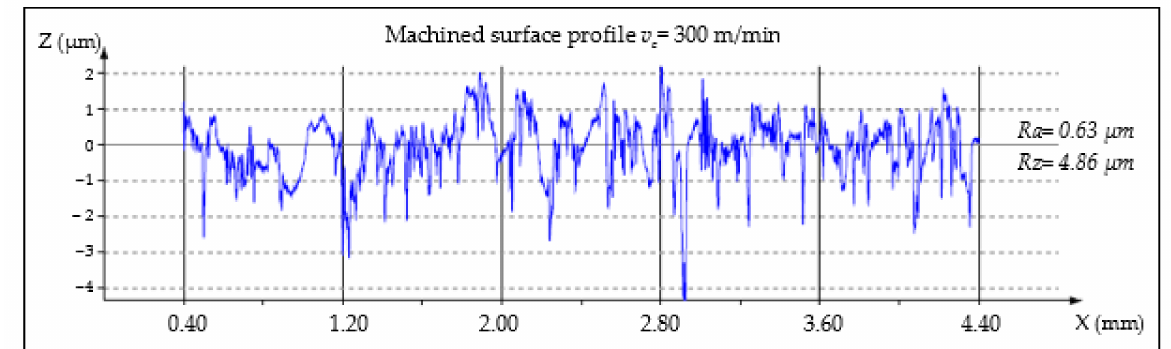
Figure 3. Machined surface profile of the AA359/SiC/10p, v c = 300 m/min, t c = 3.65